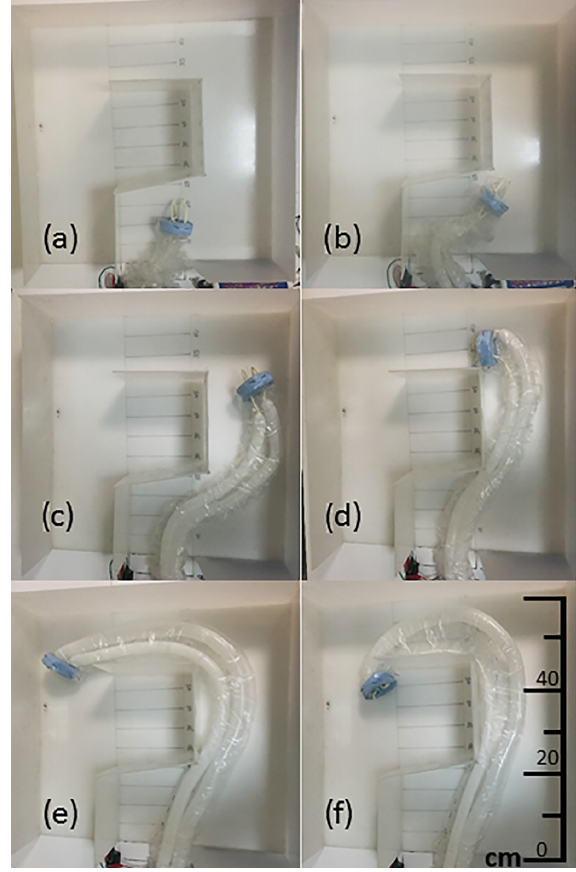
Figure 13. Robot navigating through a maze-like